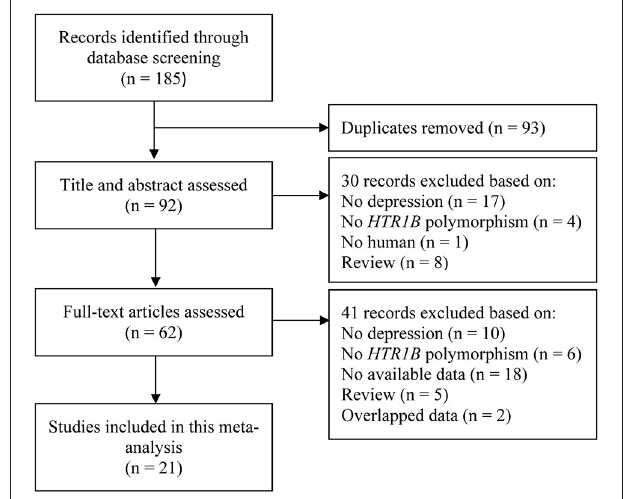
FIGURE 1 | Flow diagram of selection